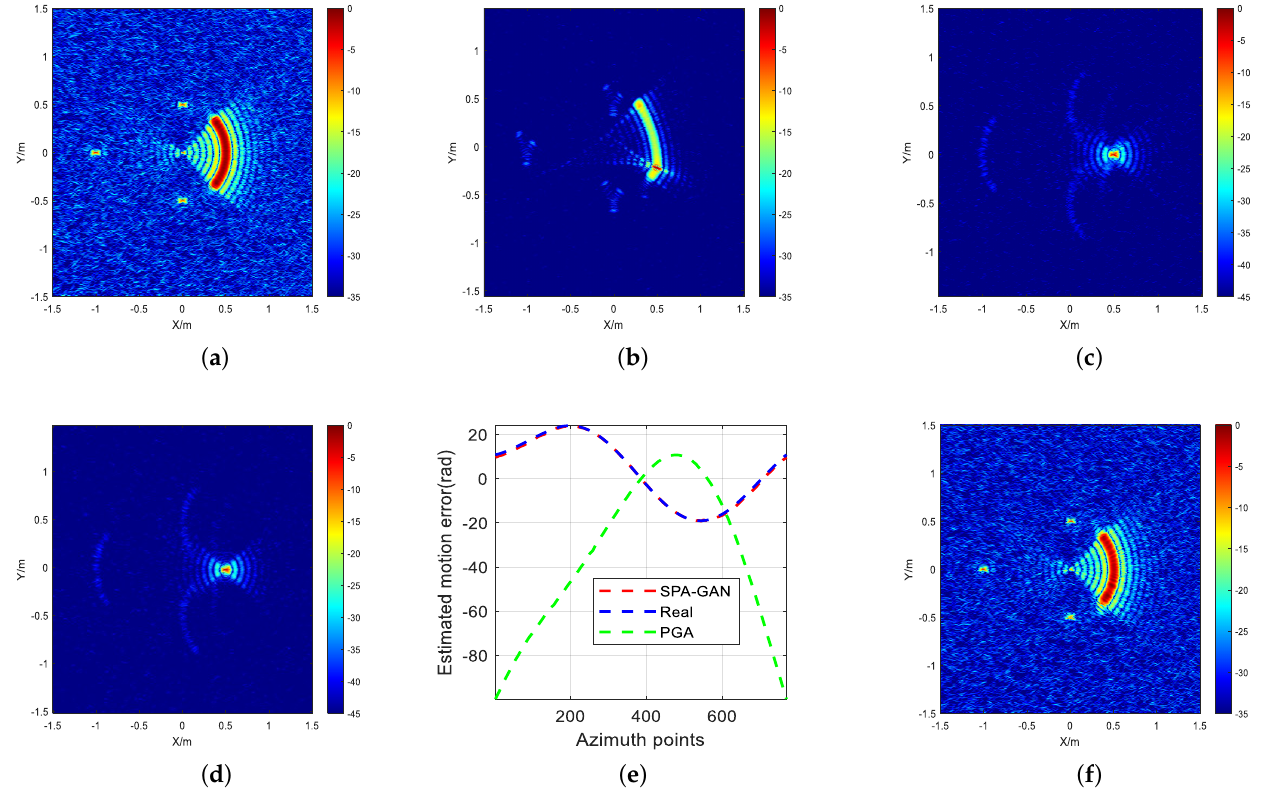
Figure 11. Simulation experiment results of an arc target and three points for SNR ≈ 23 dB: ( a ) the BP result with the ideal trajectory; ( b ) the BP result with motion error; ( c ) the PGA result; ( d ) the MSE result; ( e ) the estimated motion error of the proposed SPA-GAN, PGA and real motion error; ( f ) the proposed SPA-GAN